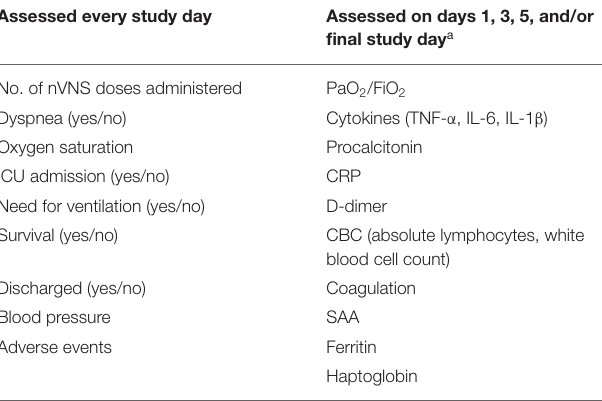
TABLE 2 | Summary of study